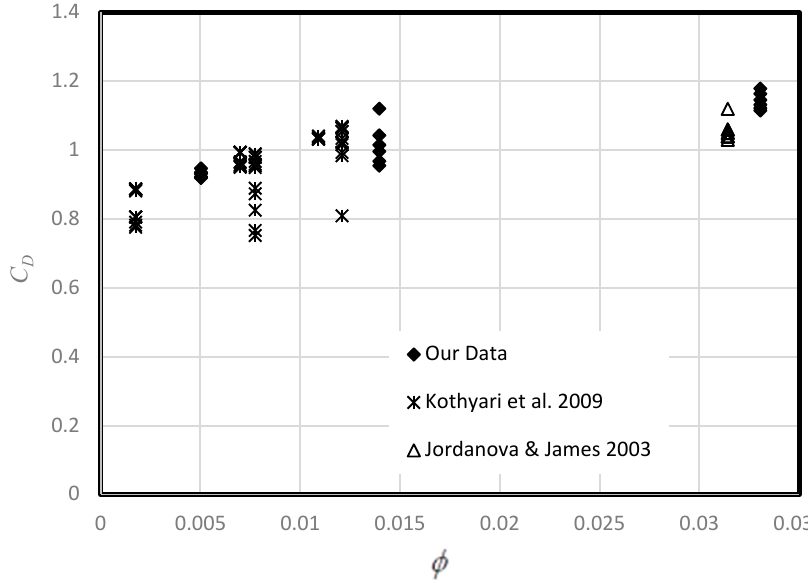
Figure 13. C D versus vegetation concentration [11, 12].